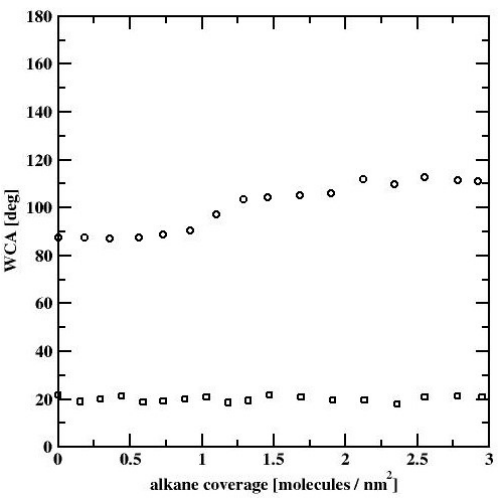
Figure 15. WCA dependence on hydrocarbon surface coverage, for water nanodroplets on n-decane covered bare silicon (circles) and silicon dioxide (squares) surfaces.